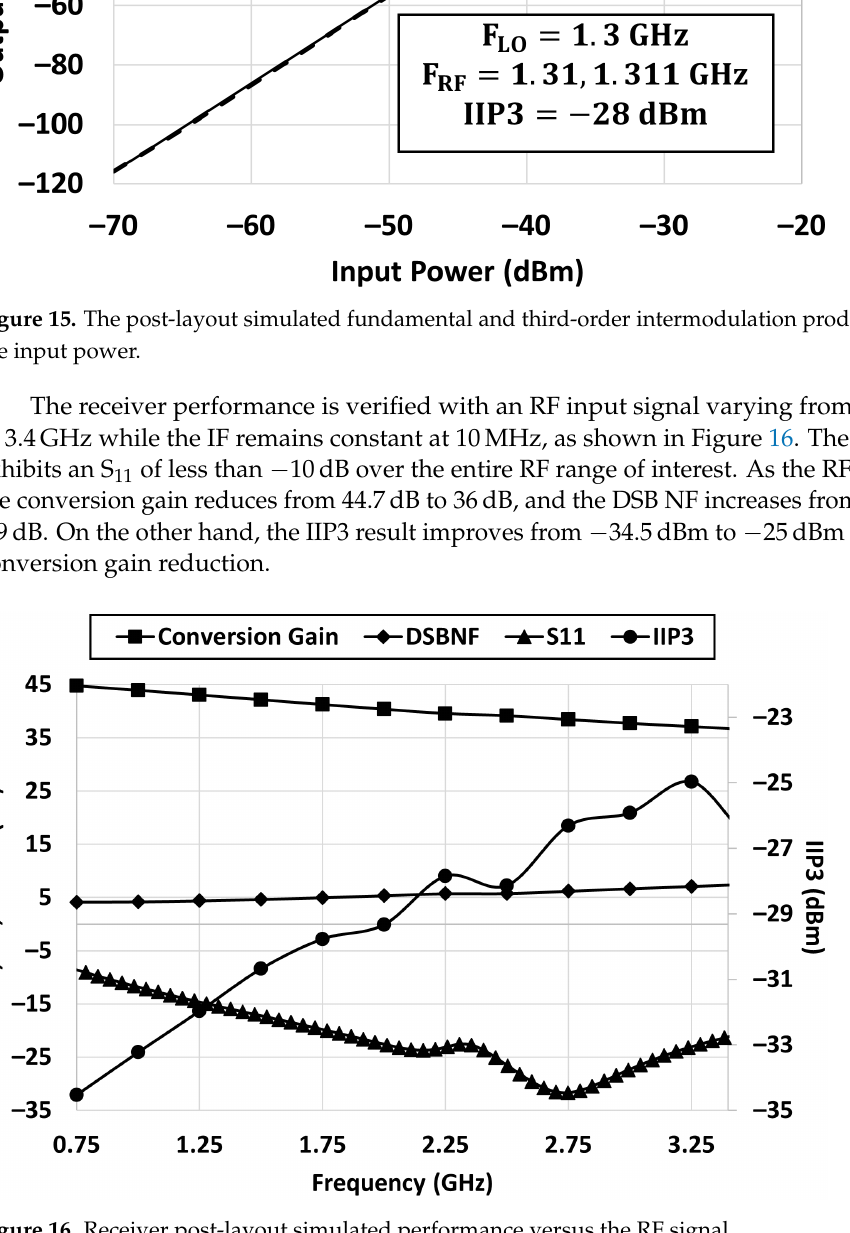
Figure 16. Receiver post-layout simulated performance versus the RF